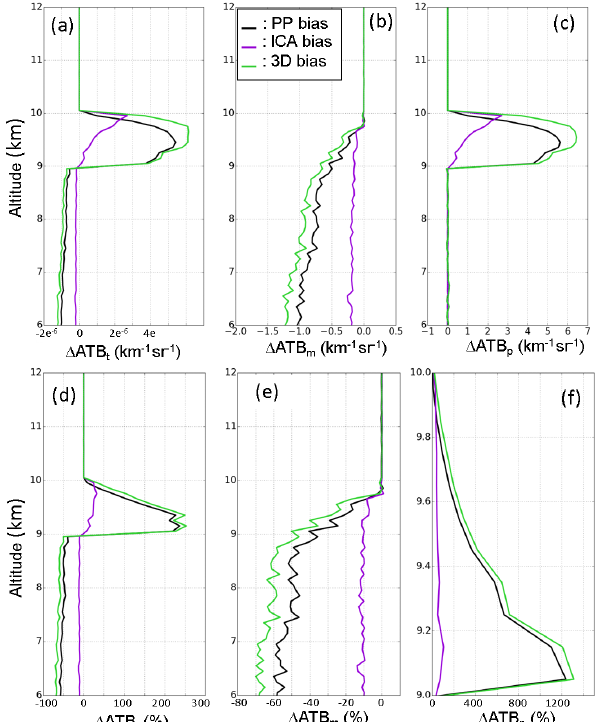
Figure 14. Vertical profiles of biases on (a) total, (b) molecular, and (c) particulate ATB and vertical profiles of relative biases on (d) total, (e) molecular, and (f) particulate ATB. Black lines rep- resent simulations using the PP cloud model, purple lines the ICA cloud model, and green lines the 3D box-cloud